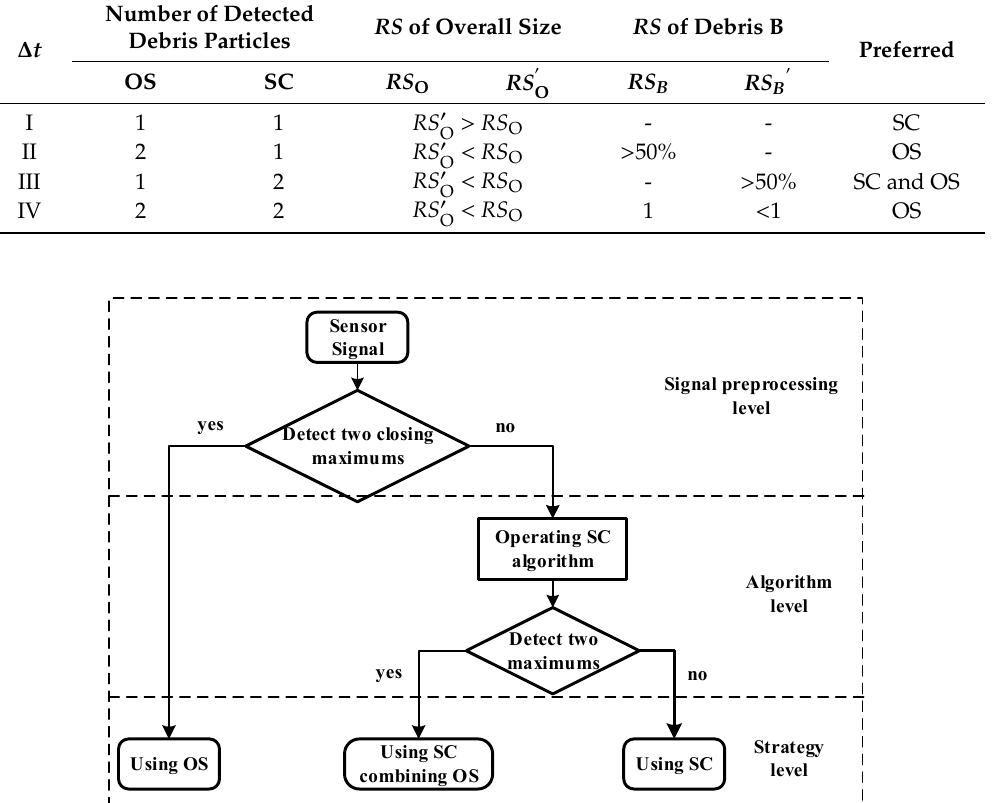
Figure 8. Aliasing signal processing strategy.